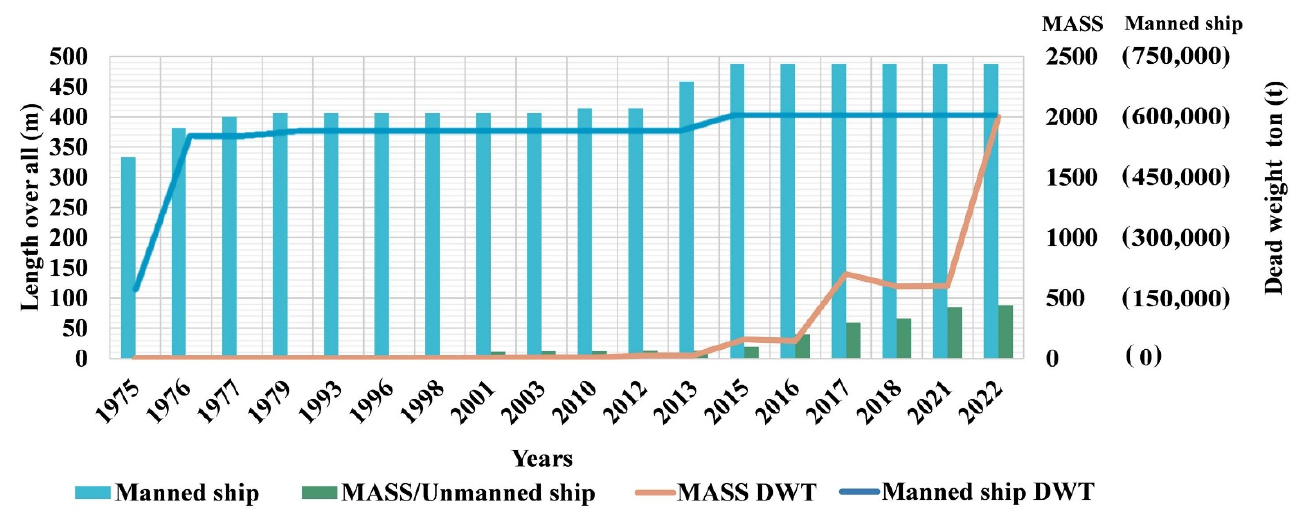
Figure 4. MASS (unmanned ship) and manned ship size change (1975–2022).